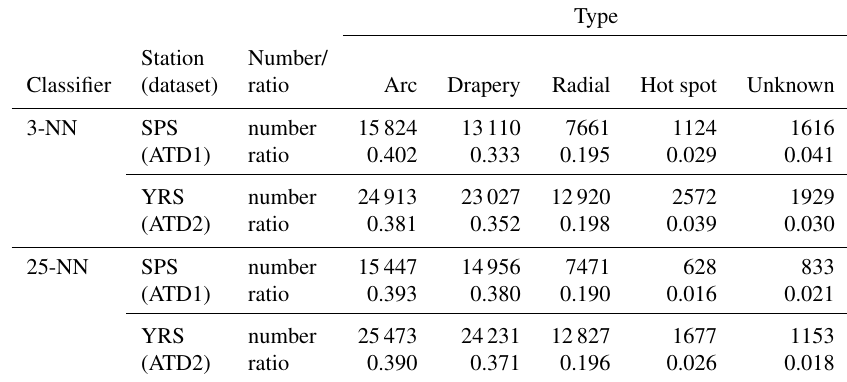
Table 3. Classification results for ATD1 of SPS and ATD2 of YRS using 3-NN and 25-NN